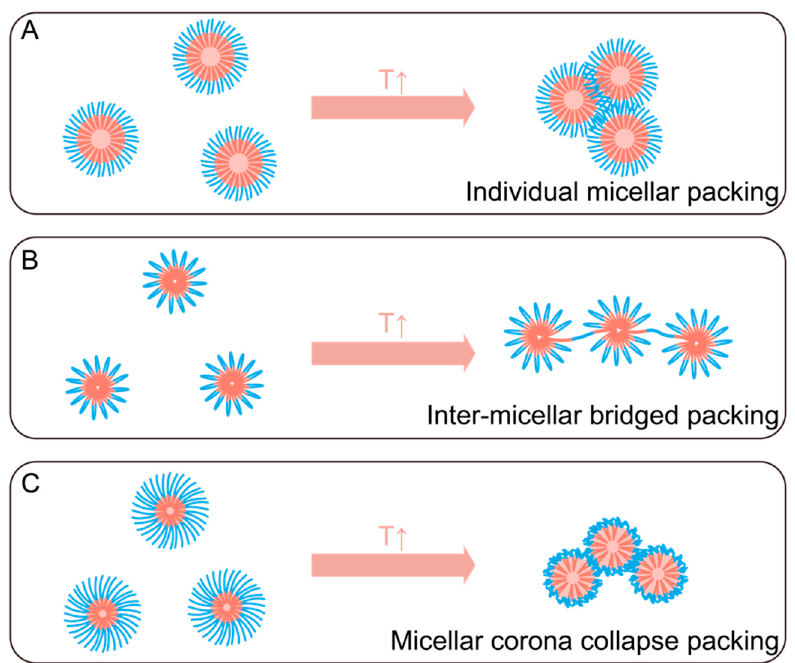
Figure 3. Micelle aggregation type of different thermogel copolymer: ( A ) individual micellar packing, ( B ) inter-micellar bridged packing, and ( C ) micellar corona collapse packing. Although amphiphilic copolymer micellization is common, amphiphilic